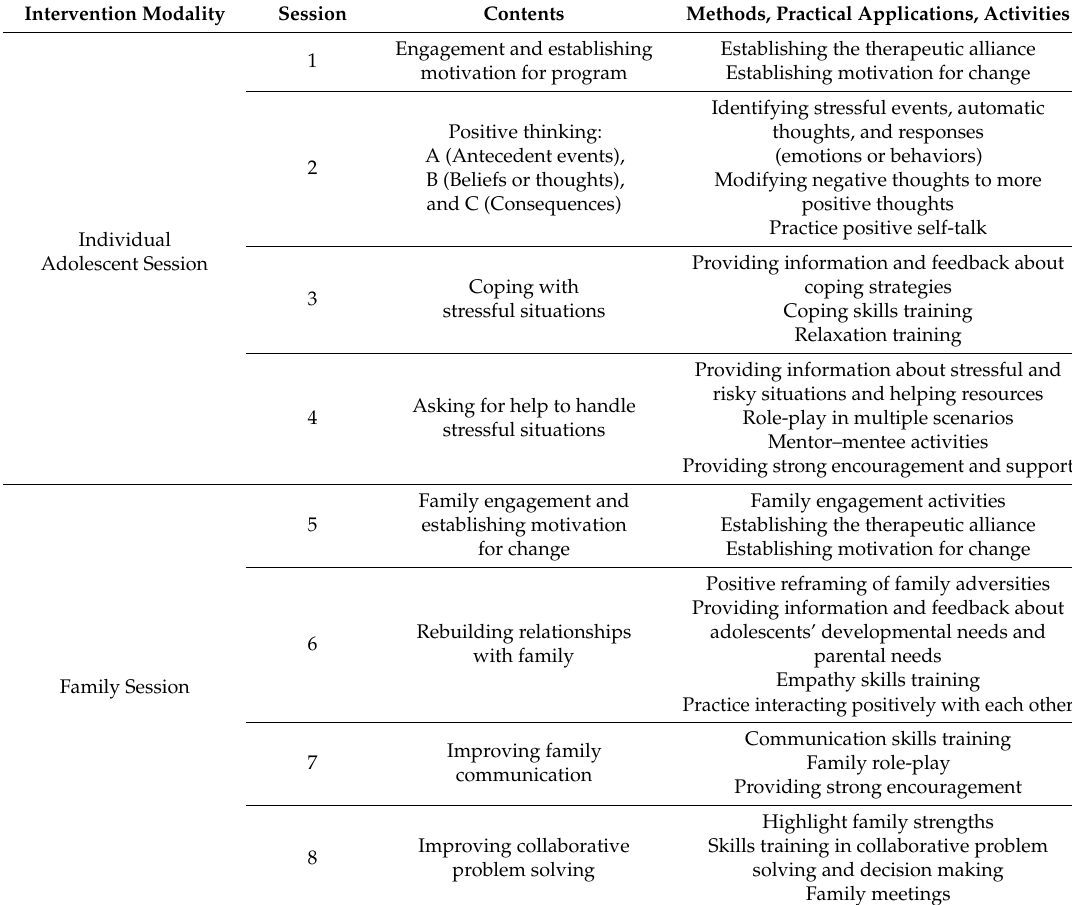
Table 3. Scope and sequence of a family-based mental health program for adolescents residing in youth